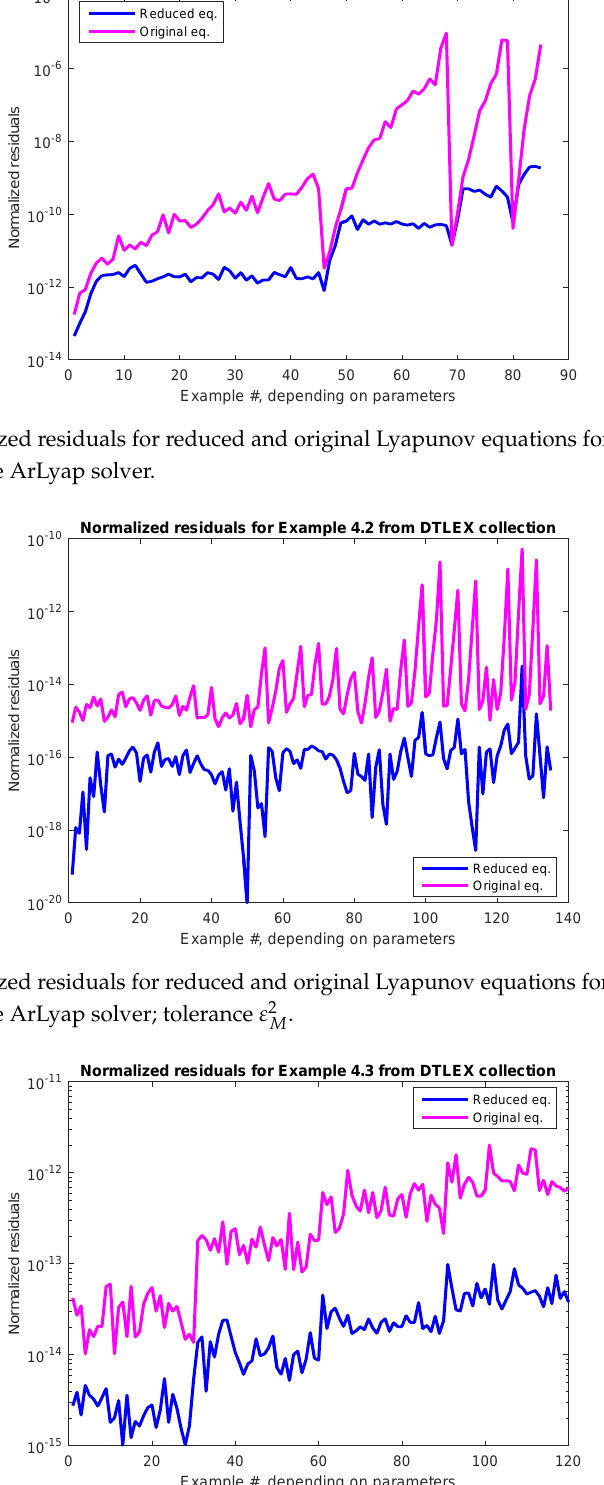
Figure 21. Normalized residuals for reduced and original Lyapunov equations for DTLEX 4.3 series of examples, using the ArLyap